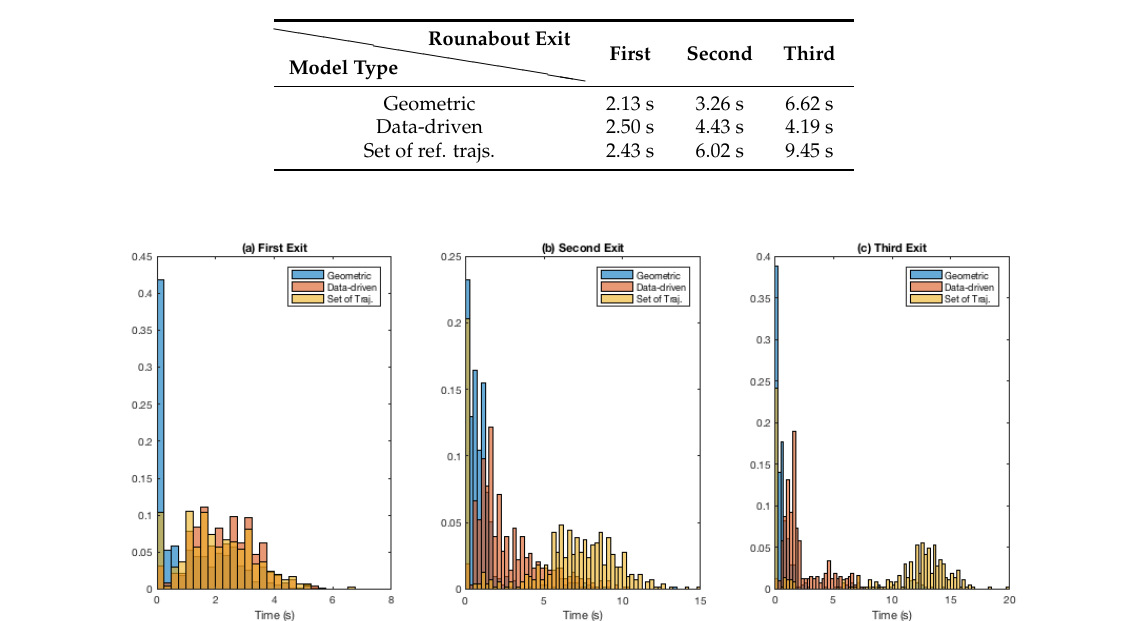
Table 5. Mean time (larger is better) from convergence to the correct exit direction until exiting from the roundabout.